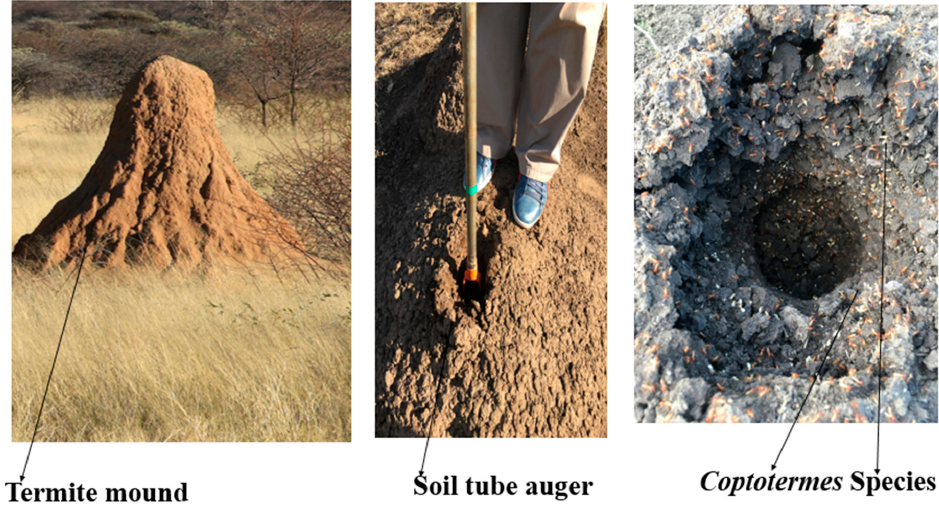
Figure 1. Termite mounds colonized by Coptotermes species.